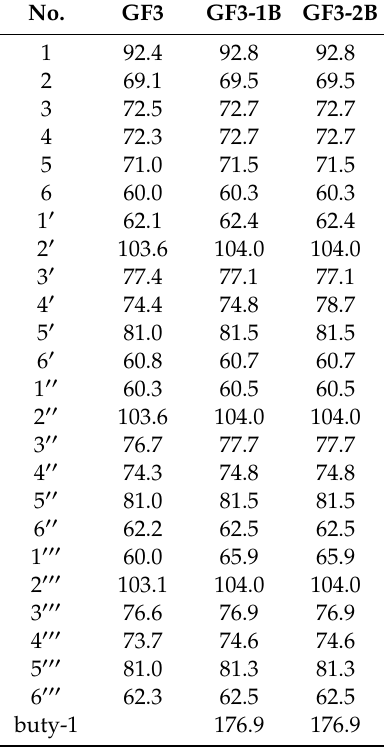
Table 2. 13 C-NMR data of fructooligosaccharide (GF3) and butyl-fructooligosaccharides (GF3-1B and GF3-2B) ( δ H in